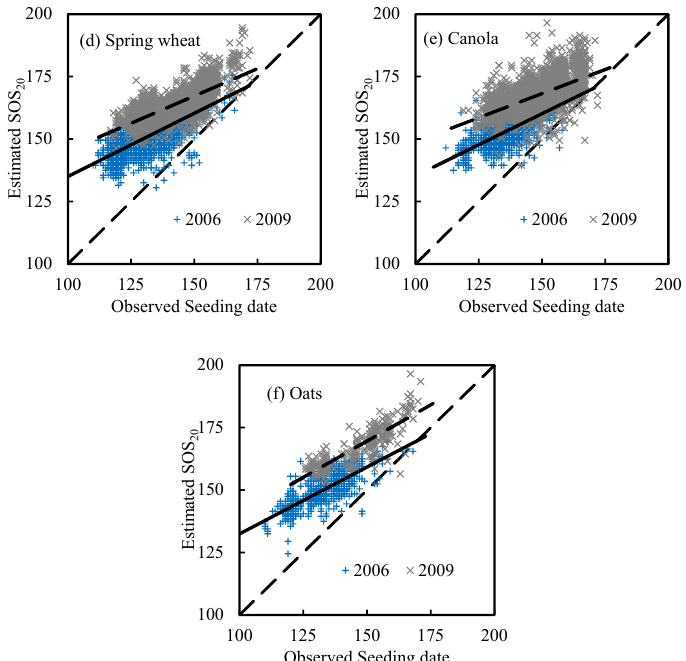
Figure 3. Scatter plot of observed seeding date and remotely sensed Start-Of-Season (SOS) for spring wheat ((a) and (d)), canola ((b) and (e)), and oats ((c) and (f)) in 2006 and 2009; DOY is the day of year. The dashed black, the long dashed black and the solid black line denote the 1:1 line, the linear regression between observed seeding date and SOS in 2006 and 2009, respectively. Table 2. Linear regression between observed seeding date (x-axis) and Start-Of-Season (SOS; y-axis); R 2 , RMSD (days) and Bias (days) are the coe ffi cient of determination, the root-mean-square -di ff erence, and the bias, respectively. Both RMSD and Bias are derived from the di ff erence between observed seeding date and